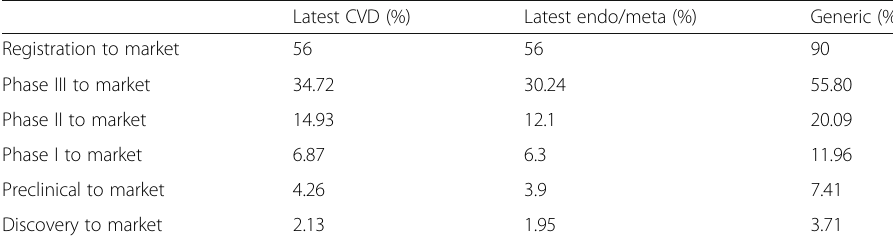
Table 5 Indication-specific cumulative success